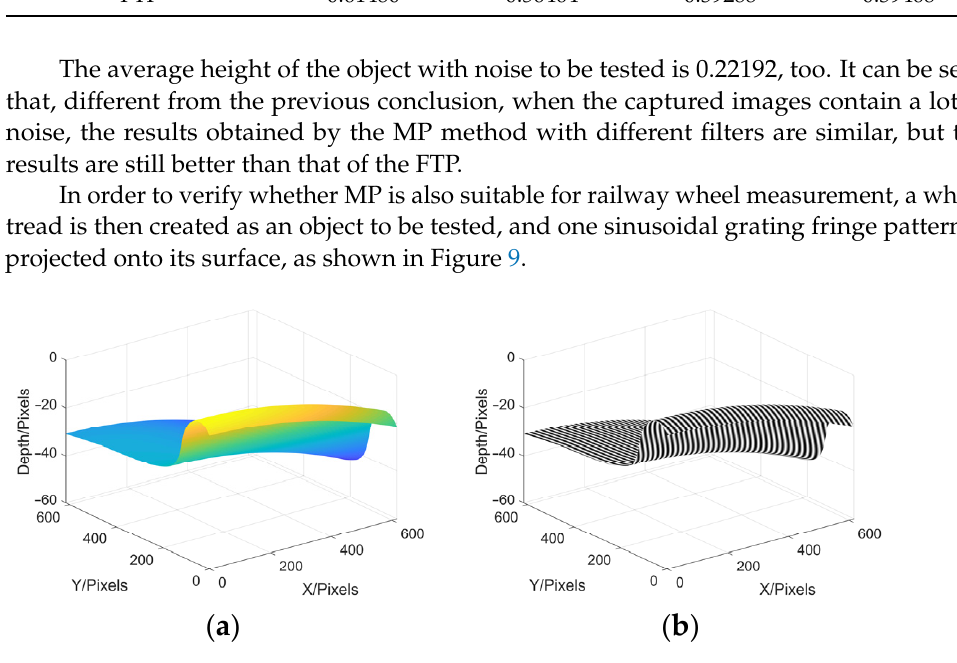
Table 3. Reconstruction errors (With noise).